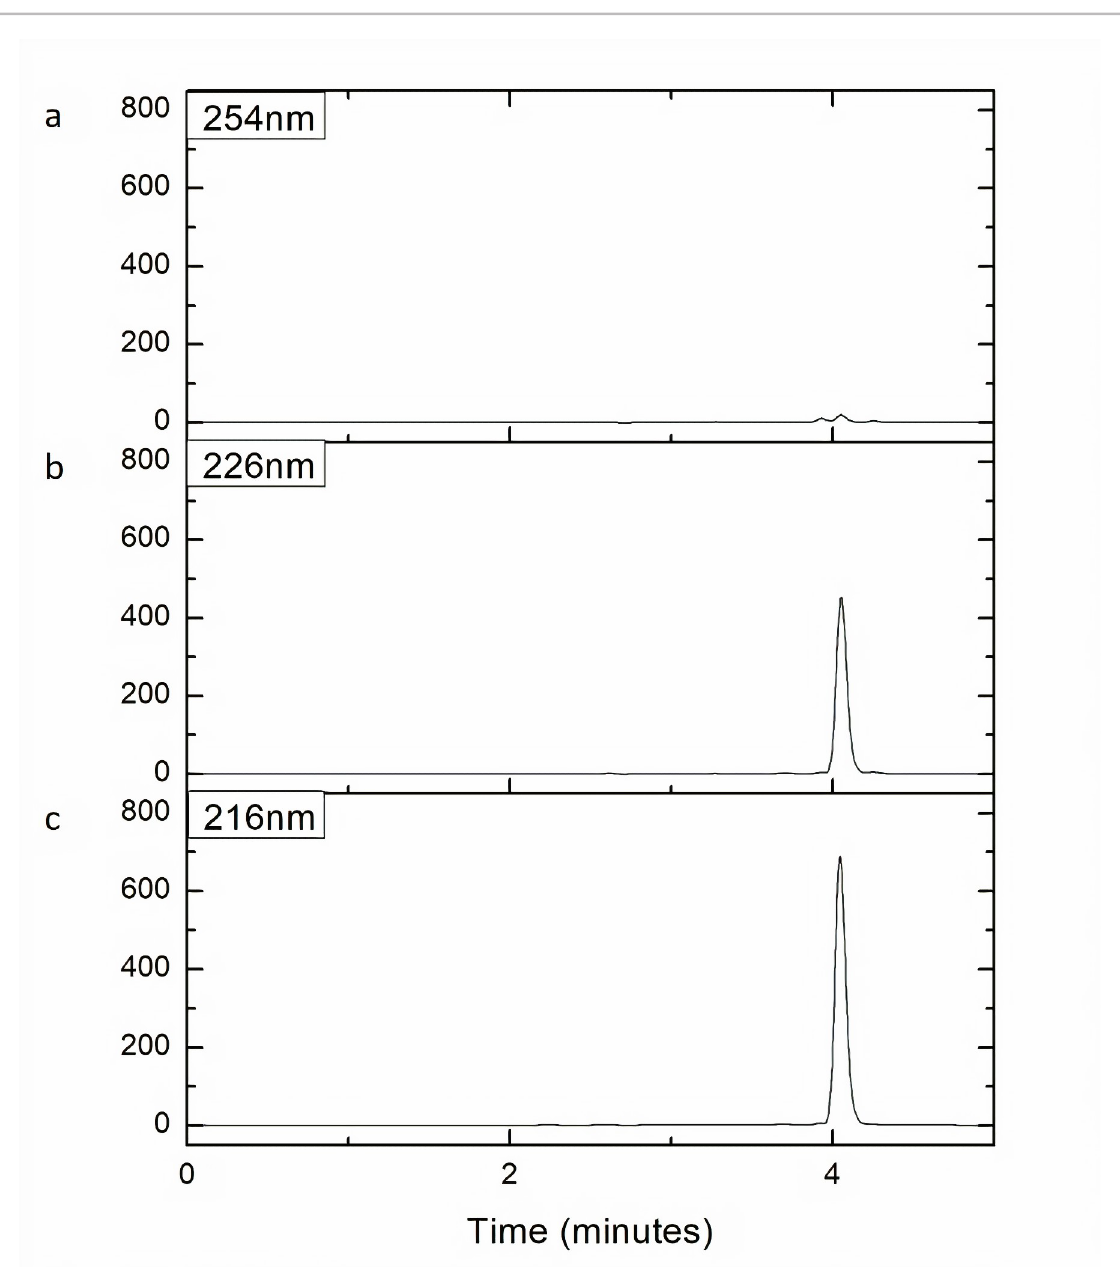
FIGURE 2 - HPLC chromatogram of 100 µ g/mL standard ACA solution at UV detection wavelengths of a) 254 nm, b) 226 nm and c) 216 nm. Conditions: mobile phase acetonitrile:water ratio of 80:20 (v/v), flow rate of 0.8 mL/min, column temperature of 25 °C, sample temperature of 25 °C, and injection volume of 10 µ